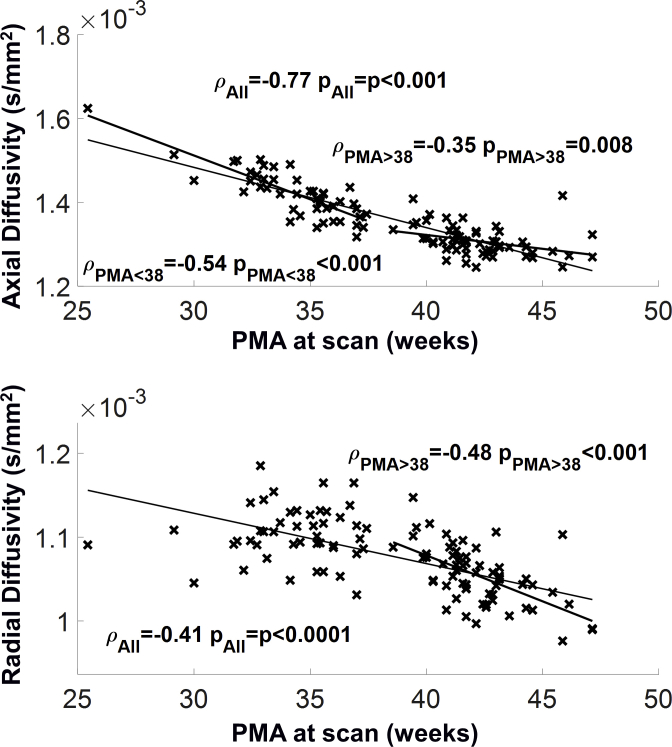
Whole-brain grey matter tissue Spearman partial correlations between Axial and Radial diffusivity and postmenstrual age (PMA) at scan.